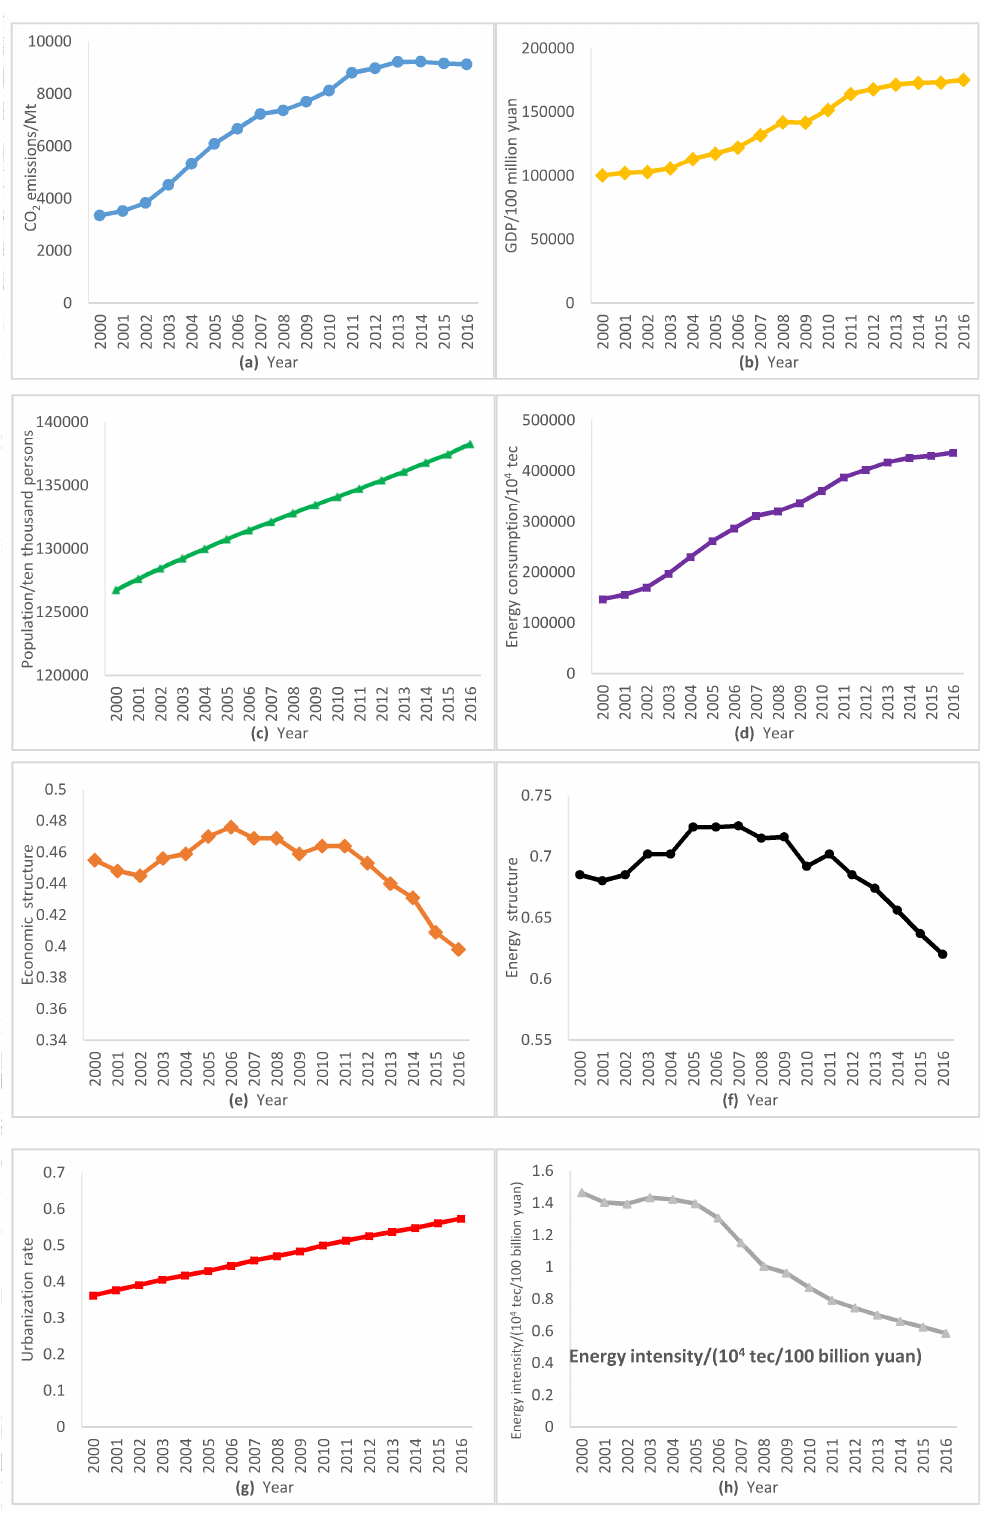
Figure 3. The sample data of CO 2 emissions and selected factors in China from 2000 to 2016. ( a ) CO 2 emissions; ( b ) GDP; ( c ) population; ( d ) energy consumption; ( e ) economic structure; ( f ) energy structure; ( g ) urbanization; ( h ) energy